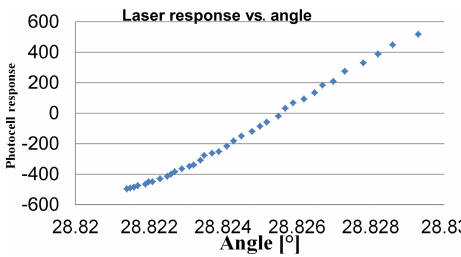
Figure 3. Photocell response when the laser points at the reflector from left to right.